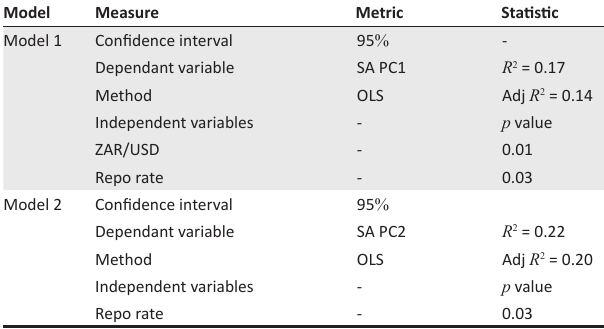
TABLE 5: Multivariate regression results: Sub-period 1. Model